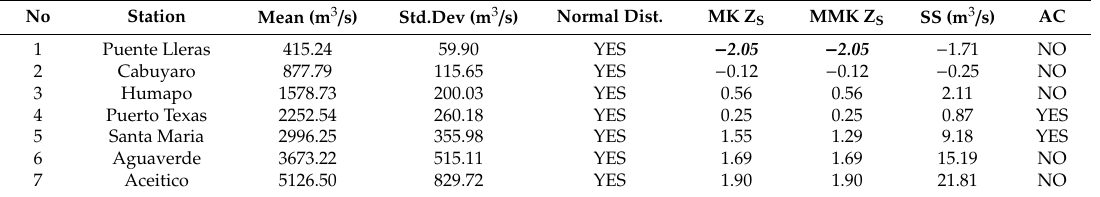
Table 5. Summary of annual average streamflow trend test using MK, MMK, and SS in the Meta